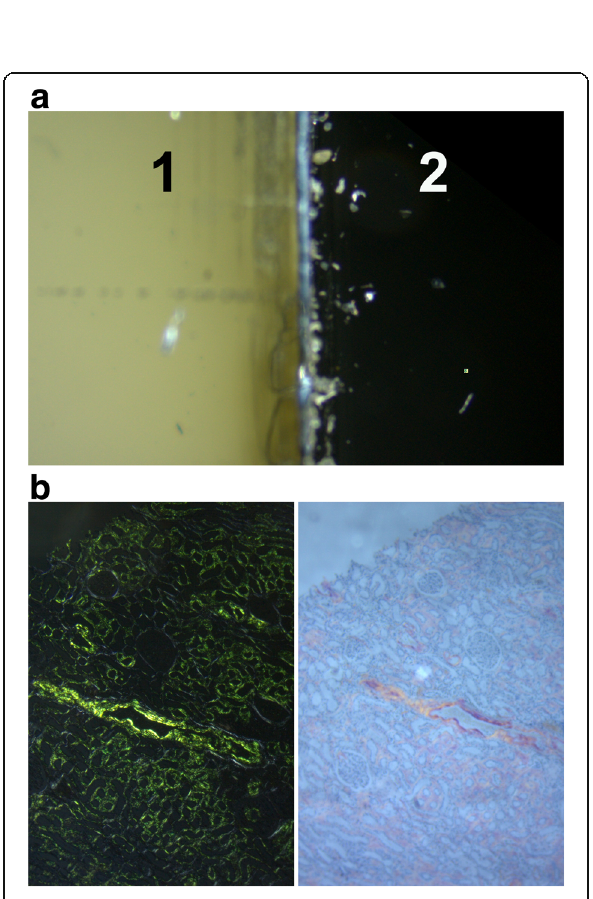
Fig. 3 a Negative impact of plastic coverslips in polarized microscopy, due to disorganized polarizing effect of some plastic polymers, it is difficult to obtain proper crossing of polarized light and light pass through on cover slip side (1) and proper dark field without the coverslip (2). b Negative impact of plastic cover slip in polarized microscopy showing positive control sample examined with glass cover slip (left) or plastic coverslip (right)